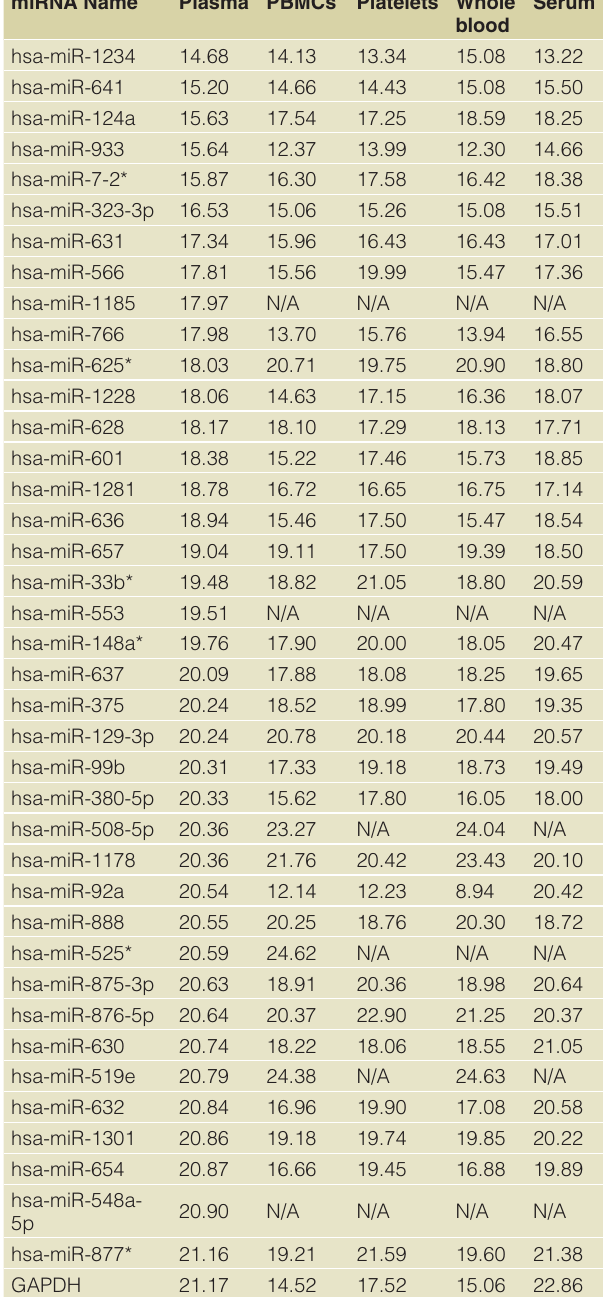
Table 1. Expression of miRNAs from whole blood, isolated platelets, mononuclear cells, plasma, and serum from healthy subjects (mean Ct values has shown; higher value indicates lower expression).